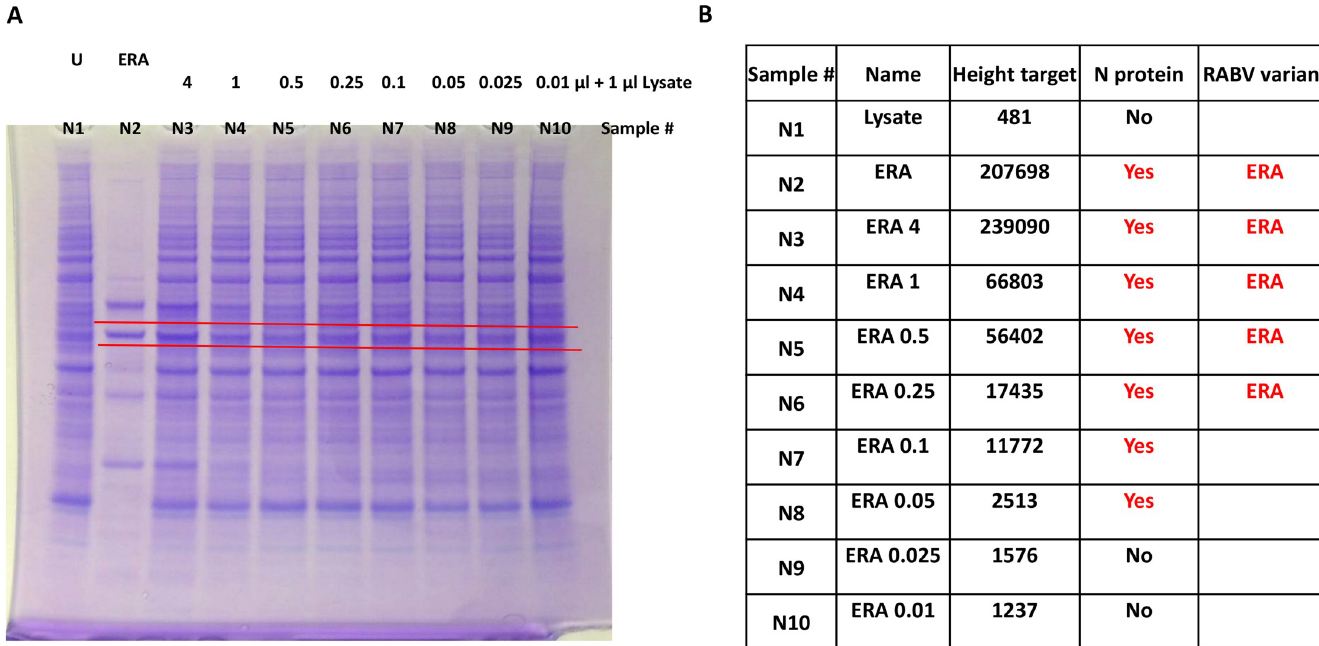
Fig 4. The limit of N protein detection by MS. (A) Different volume of purified RABV ERA virus was added to 1 μ l of uninfected cell lysate. The position of the gel corresponding to N protein (marked by red lines) was sliced, in-gel tryptic digested and analyzed by MS. U–uninfected cell lysate, ERA–purified RABV ERA virus. (B) MS results for different gel slices. Height target above 2000 is considered as the cut-off for N protein detection. ERA–denotes to the samples in which N protein variant was identified by MS/MS fragmentation based amino acid sequencing.